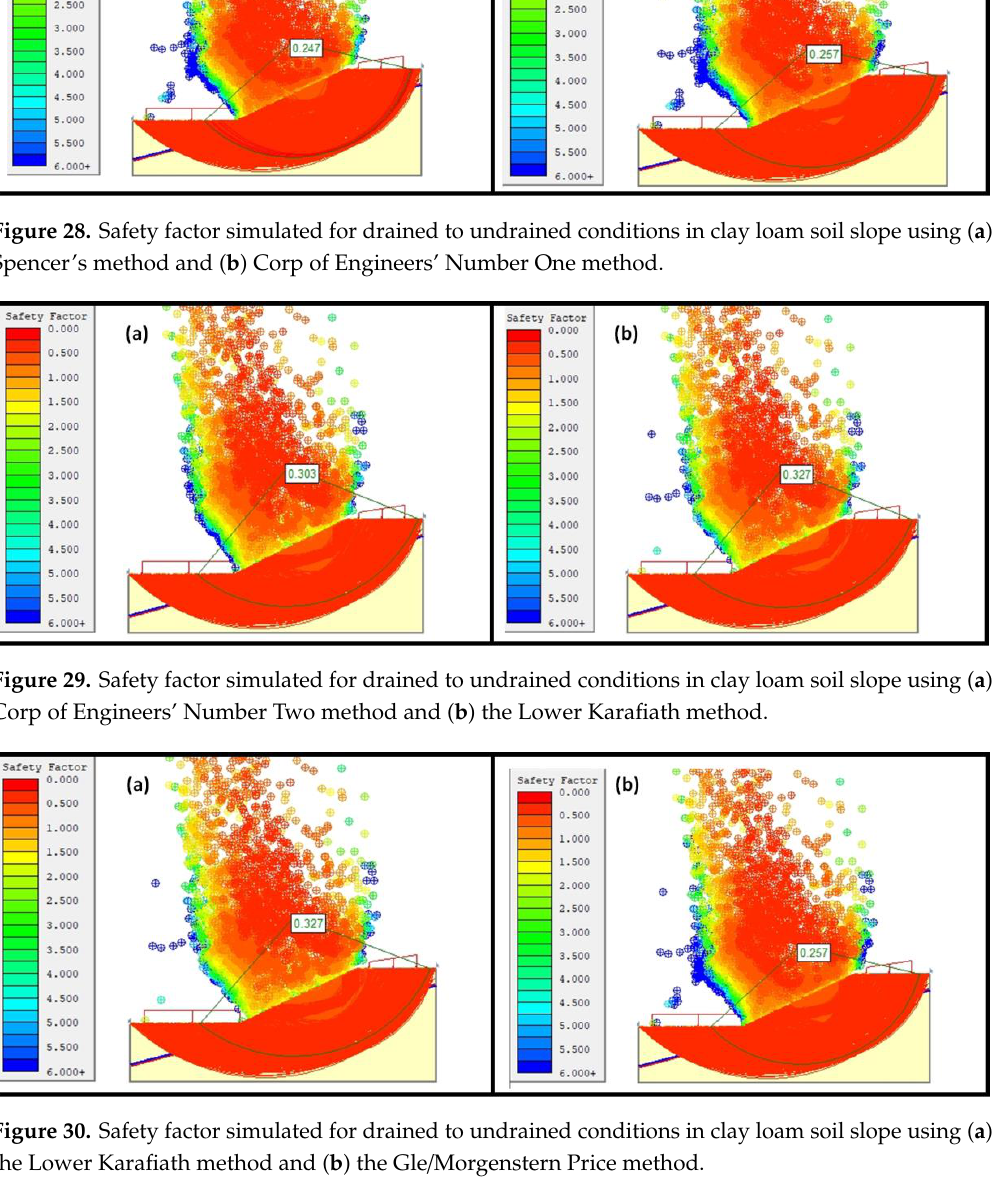
Figure 30. Safety factor simulated for drained to undrained conditions in clay loam soil slope using ( a ) the Lower Karafiath method and ( b ) the Gle/Morgenstern Price method. Simulations of the FoS Using FLACSlope (FDM) Model under Sunny to Rainy Conditions in Clay Loam Soil Slope